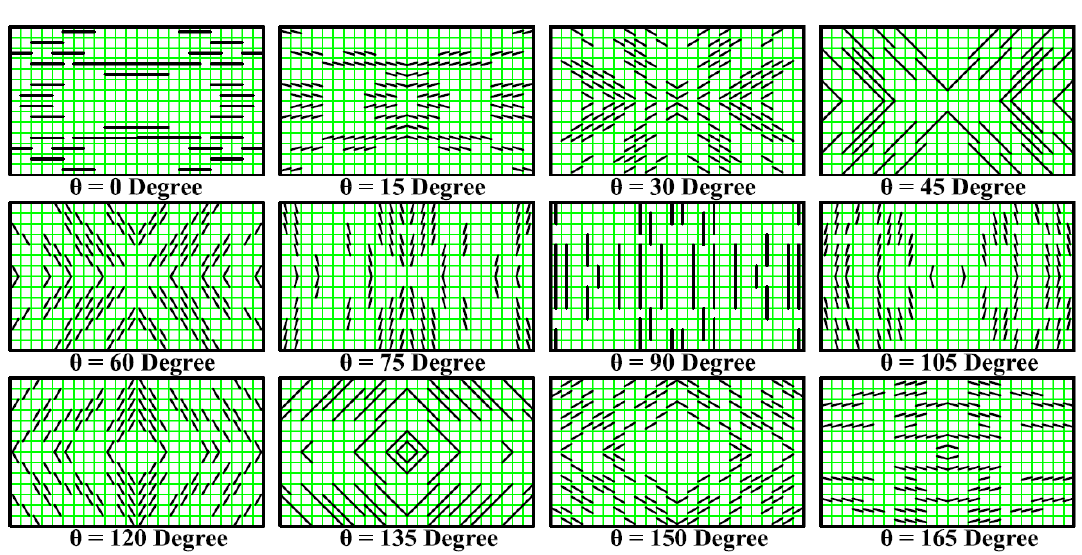
Figure 10. Example of the crack patterns for the studied dataset.